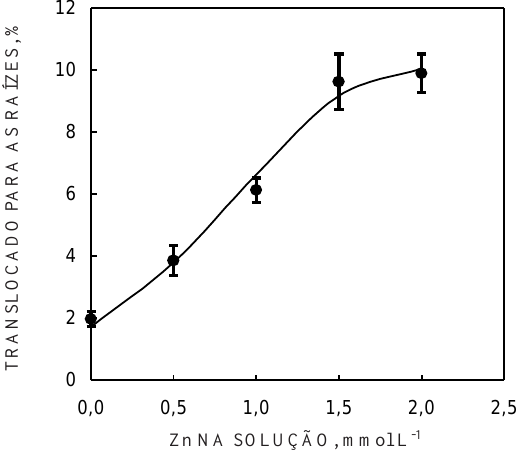
Figura 5. Proporção do zinco aplicado às folhas de milho que foi translocada para o sistema radicu- lar da planta, considerando a concentração do nutriente na solução nutritiva (y = exp(0,55 + 1,81x - 0,47x 2 ); R 2 = 0,96). As barras verticais mostram o desvio-padrão dos